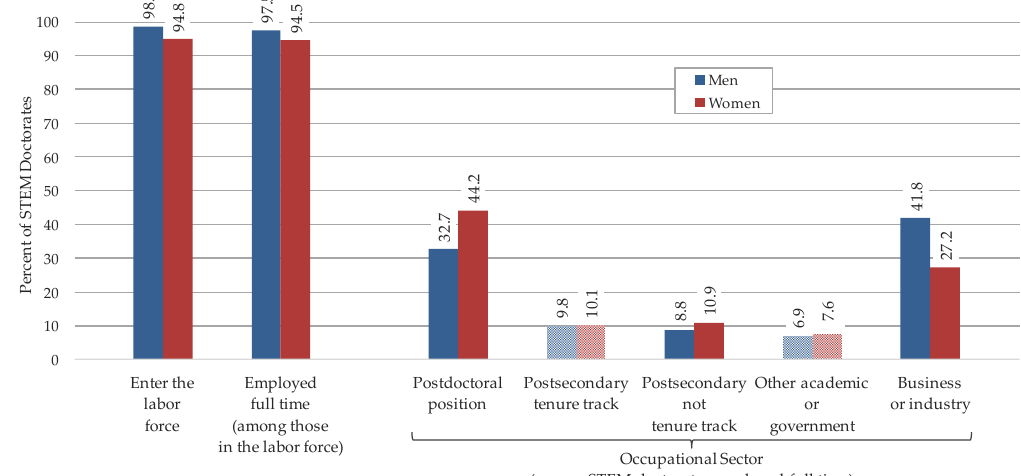
Figure 2. Probability of employment states by gender. Source : Author’s calculations using data from the Survey of Doctorate Recipients [22] and the O*NET Occupational Information Network Database [23], 1995–2013. Note: Solid bars represent gender differences that are significant at α = 0.05.